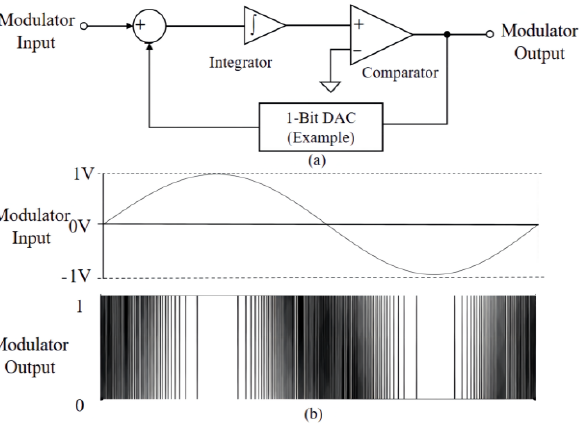
Figure 9. The structure of Δ - Σ modulator ( a ) and the comparison of input and output signal ( b ).